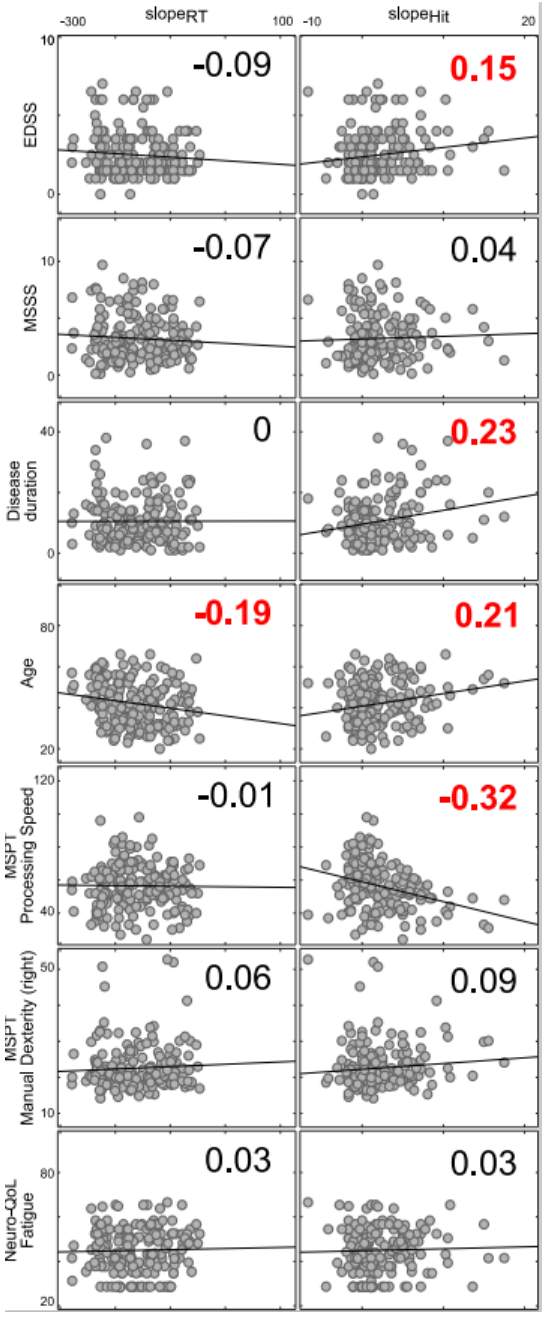
Figure 3. Results of correlation analysis. The numbers denote the correlation coefficient. Red font color indicates significant correlations ( p < 0.05). EDSS: Expanded Disability Status Scale; MSSS: Multiple Sclerosis Severity Score; MSPT: Multiple Sclerosis Performance Test; Neuro-QoL: Quality of Life in Neurological Disorders.